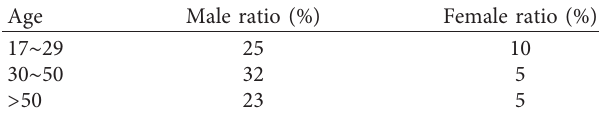
Table 3: Form of experiment participants’